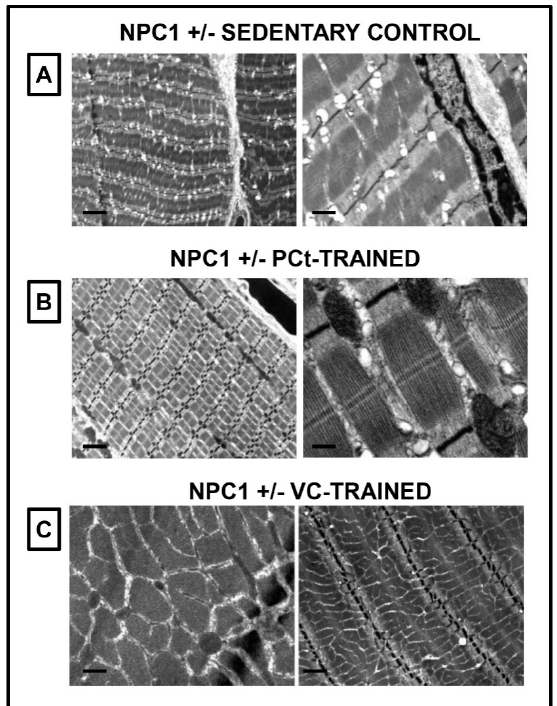
Figure 3. Muscular plasticity adaptation following training with the different protocols. ( A ) The ultrastructural analysis of the muscle tissue of NPC1 +/ − SEDENTARY CONTROL mice showed moderate misalignment of the sarcomeres and scarce localized vacuolizations between the